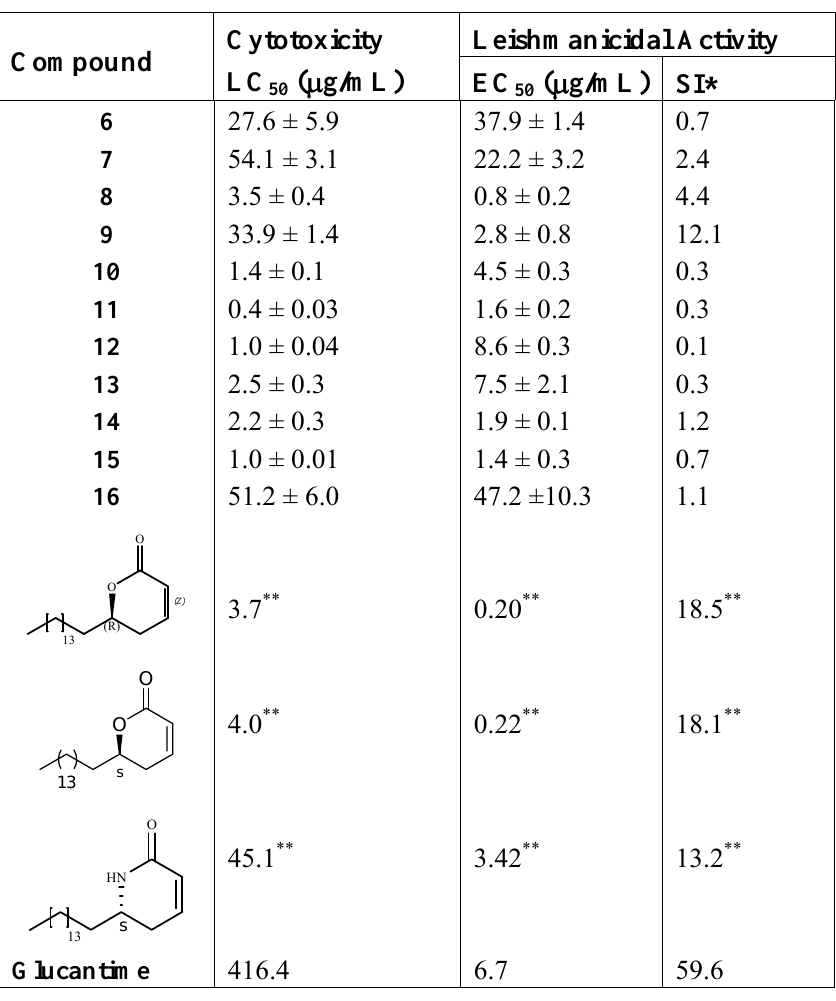
Table 1. Evaluation of synthetic lactones activity against Leishmania